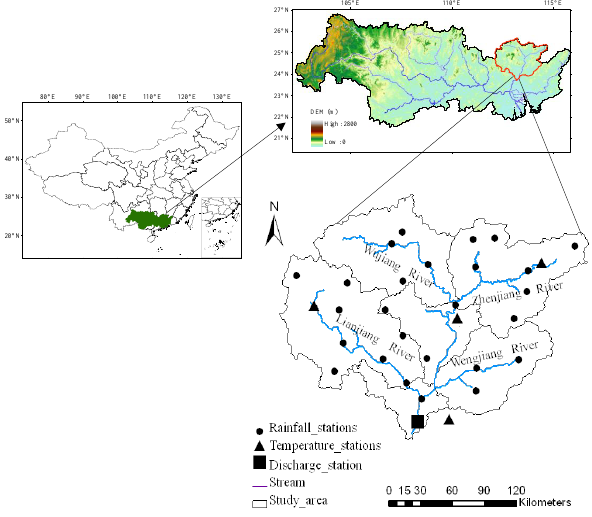
Figure 1. Map showing the location of study